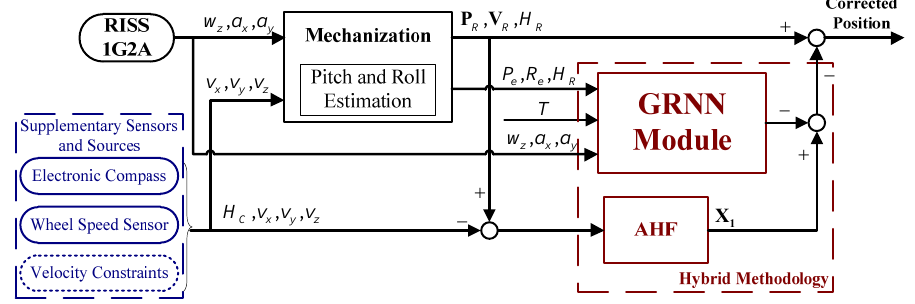
Figure 2. Diagram of the proposed positioning solution (prediction mode).